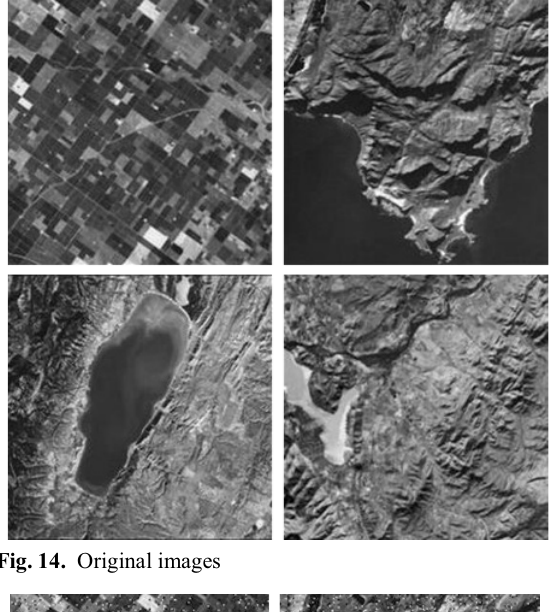
Fig. 13. Median filter test bench result